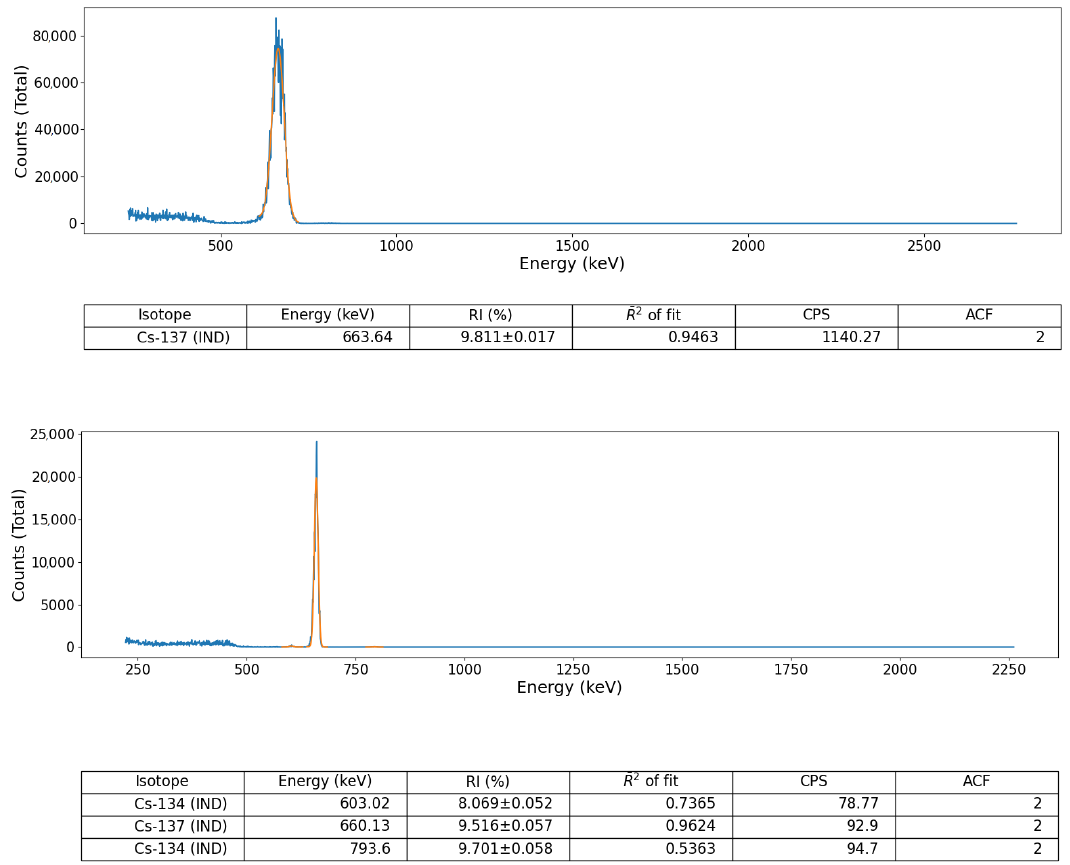
Figure 6. Peak-identified gamma-ray spectra, derived online (live), for the Cs-137 contaminated soil sample. Collected using a Hamamatsu C12137-01 CsI(Tl) scintillator type spectrometer module ( top ), and a Kromek GR1 CdZnTe (CZT) semiconductor type micro-gamma spectrometer ( bottom